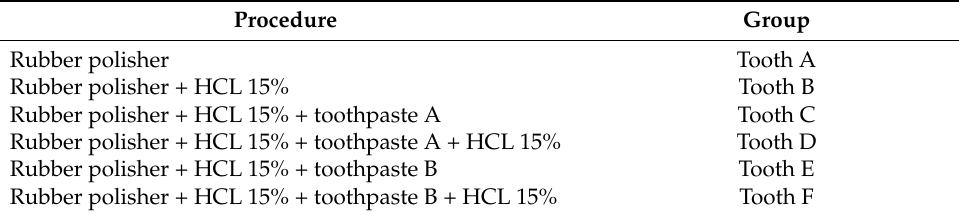
Table 1. Groups divided by surface